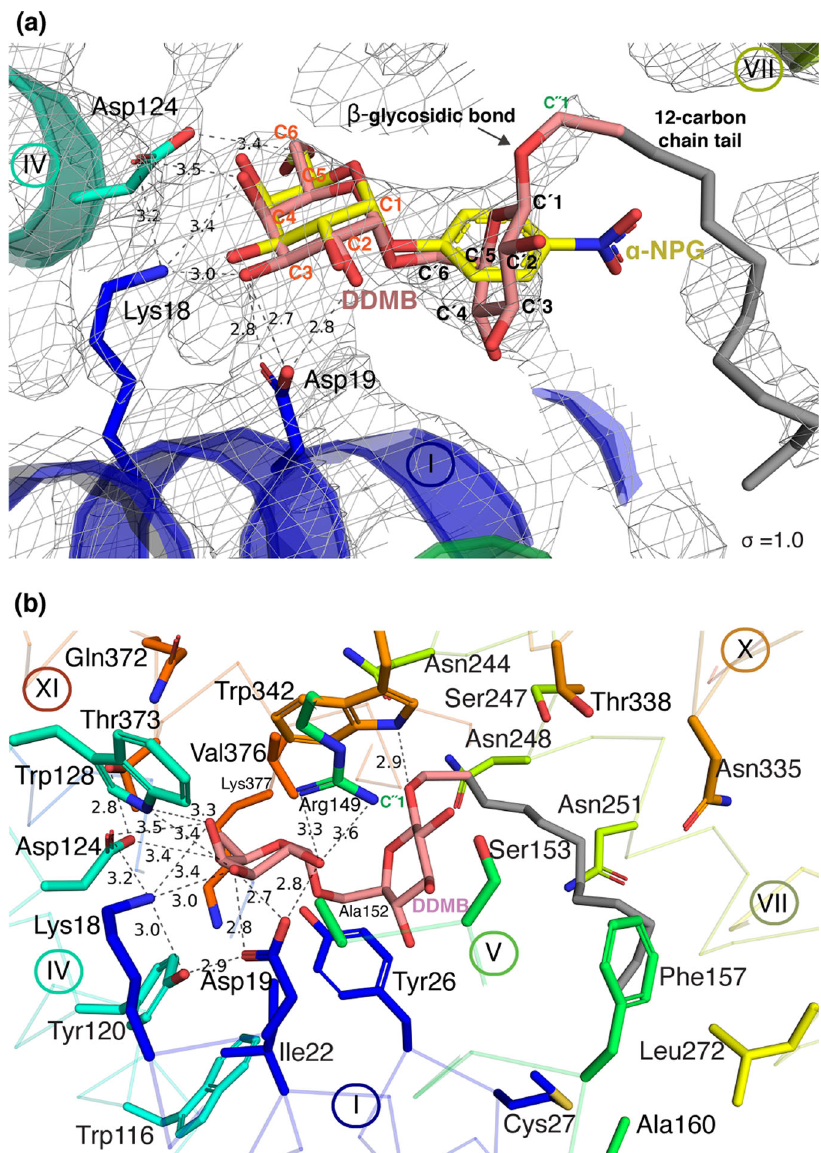
Fig. 4 DDMB-binding site. The structure with bound DDMB was re fi ned to a resolution of 3.15 Å [PDB ID, 7L16]. Carbon positions are indicated (also presented in Fig. 1). The C3 to C12 on the detergent chain tail are presented in gray due to lack of electron density. H-bond and salt-bridge interactions are judged by distance ≤ 3.5 Å and indicated by dashed lines with distance shown in Å. a 2Fo-Fc electron-density map. Ο ne molecule of DDMB was fi tted to the density map (contoured to 1.0 σ ). Τ he α -NPG in the α -NPG-bound structure, which was aligned to the DDMB-bound structure, is included for the comparison. b DDMB-binding site. Similar contacts between MelB St and the galactosyl moiety observed in the α -NPG binding also exist in DDMB binding. Trp342 (helix X) forms a H-bond with C ′ 1 O atom on the glucosyl ring; Lys18 adds one more H-bound to C4-OH of galactosyl moiety; Tyr120 adds one more bifurcated H-bond to Asp19; and C6-OH is at a longer distance to Asp124. Helices are shown in ribbon. Few more sidechains including Cys27 (Helix I), Ser153 and Ala 160 (helix V), and Asn244/248/251 (helix VII), and Asn335 and Thr338 (helix X) are at distances of less than 6 Å to the glucosyl moiety or the